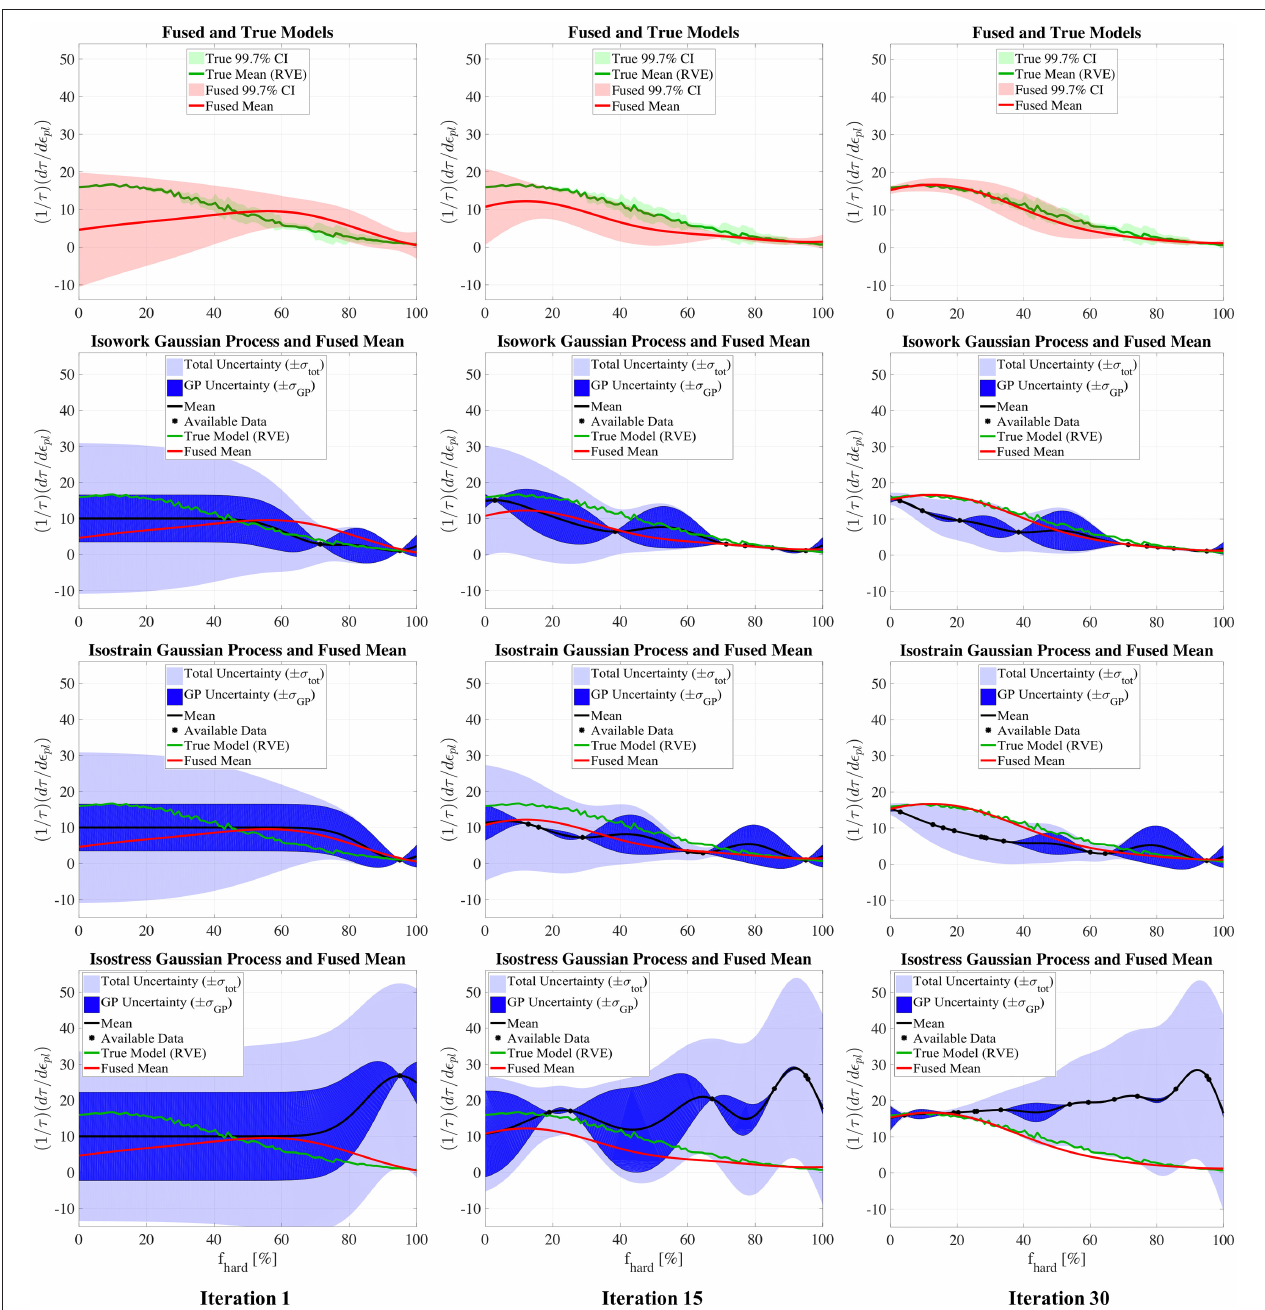
FIGURE 9 | The fused model and Gaussian processes of the isowork, isostrain, and isostress models in comparison with the true (RVE) model in iterations 1, 15, and 30. Image sourced from Ghoreishi et al. (2018); use permitted under the Creative Commons Attribution License CC-BY-NC-SA.